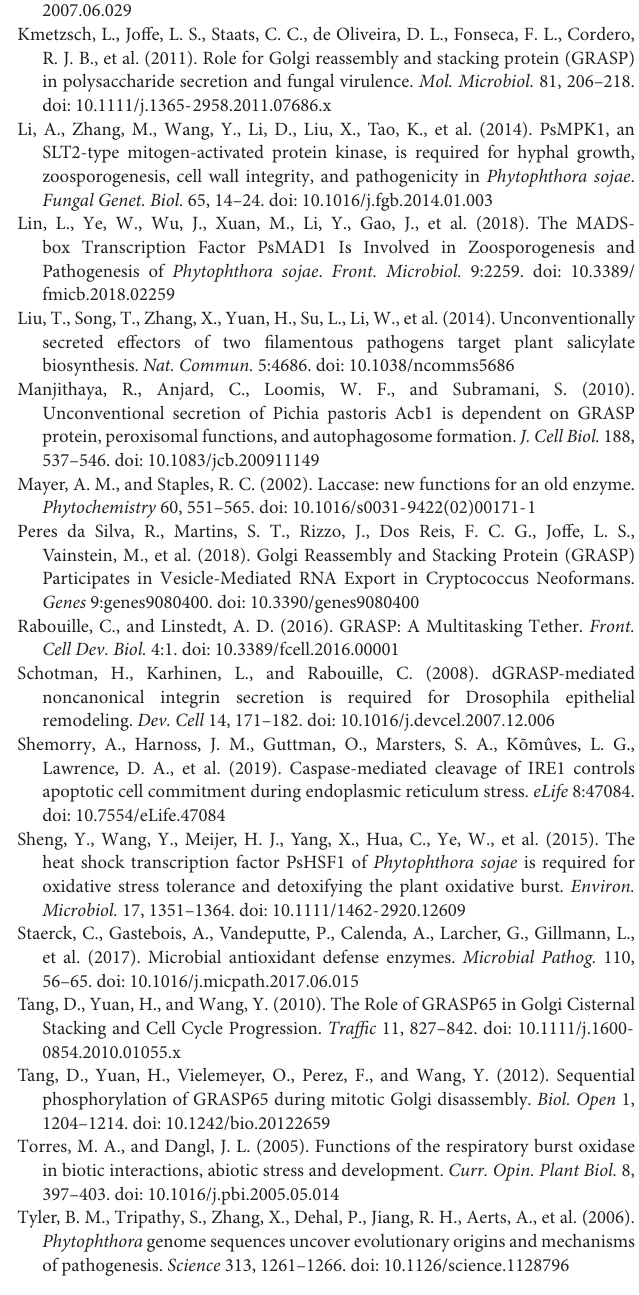
profile on SDS-PAGE and concentration of each protein protocol for P6497 and T12. M, protein ladder molecular weight. (B) The number of differentially